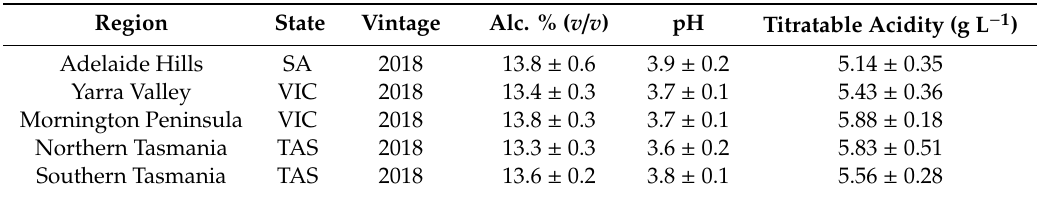
Table 1. Regional means ( ± standard deviation, SD) of basic oenological attributes of the sample set of Pinot noir wines used ( n = 3 per